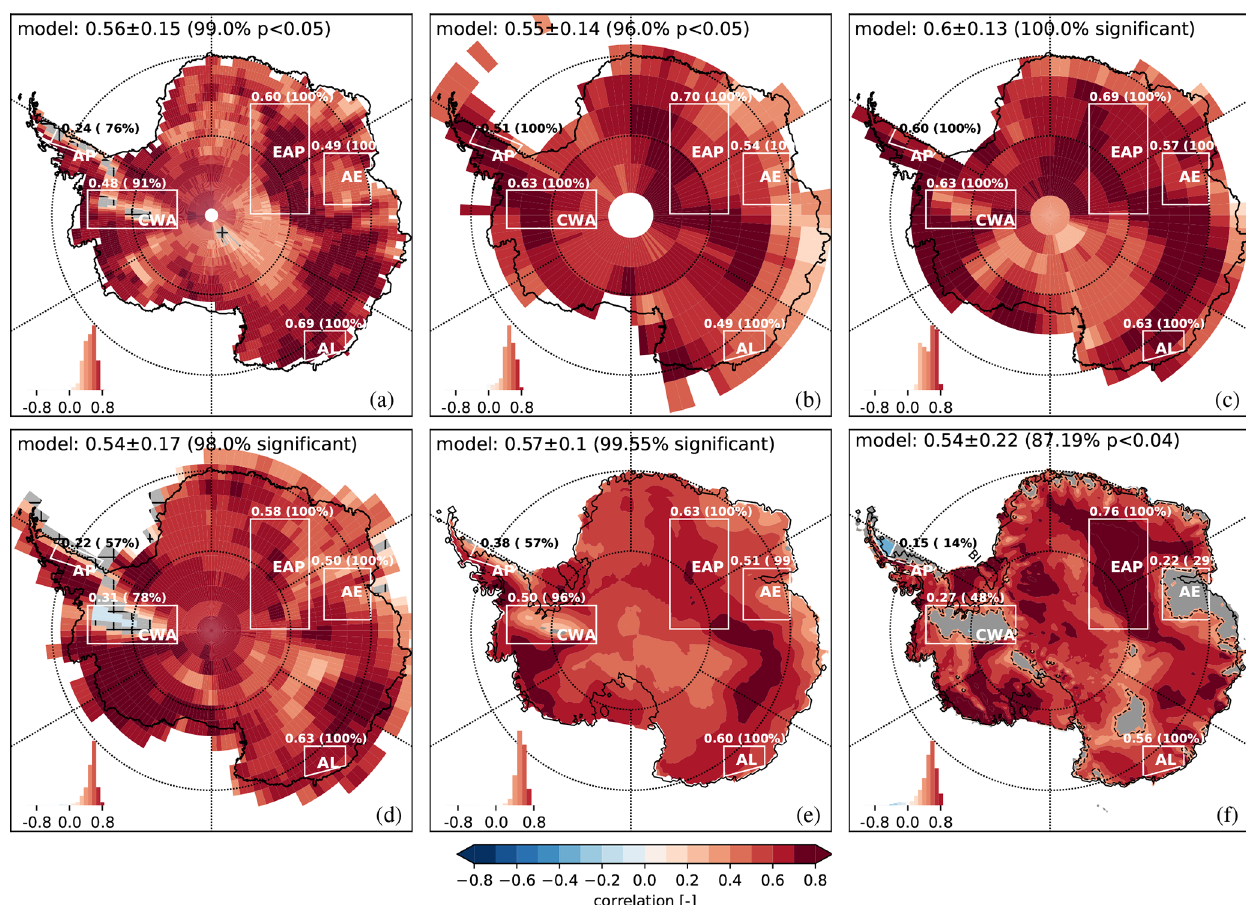
Figure 1. Annual correlation between SMB and SAT over 1871–2000 for (a–e) : (a) ECHAM5-wiso, (b) ECHAM5-MPI/OM, (c) iHadCM3 (seven-simulation average), (d) iCESM1 (three-simulation average), and (e) averaged over all the isotopic GCMs. Annual correlation between SMB and SAT over 1979–2016 for RACMO2.3 at the 27km spatial resolution for (f) . Statistically insignificant areas ( p > p FDR , the threshold p value calculated) are in grey. The histogram displays the distribution of correlation values. Continent-wide annual correlation mean, standard deviation, and percentage of model area with p < p FDR are provided in each panel (for e , average over all four isotopic GCMs). The five regions mentioned are annotated as follows. AE: Amery Embayment; AL: Adélie Land; EAP: East Antarctic Plateau; AP: Antarctic Peninsula; CWA: central West Antarctica; BI: Berkner